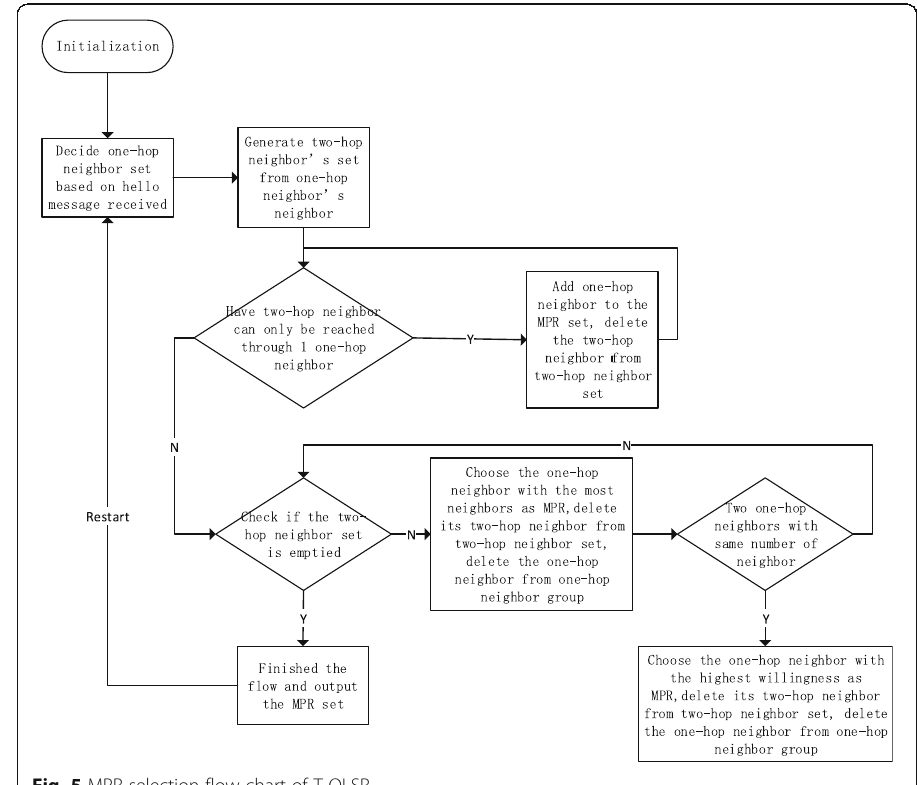
Fig. 5 MPR selection flow chart of